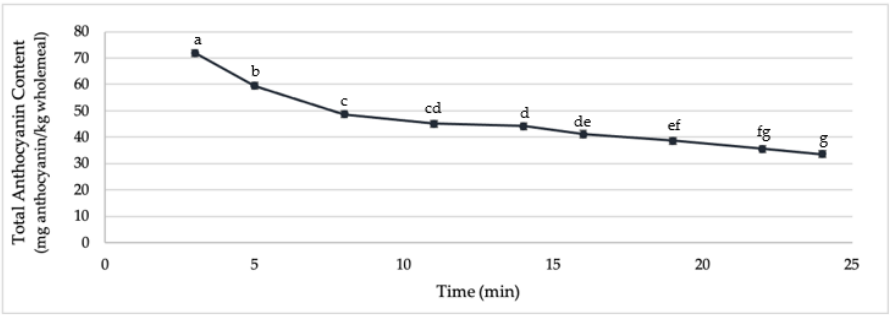
Figure 2. Total anthocyanin content (in mg anthocyanin/kg wholemeal) of dough/bread made from AnthoGrain™ wholemeal, baked for 3, 5, 8, 11, 14, 16.5, 19, 22, and 24 minutes. (Samples with dif- ferent letters are significantly different at α = 0.05).